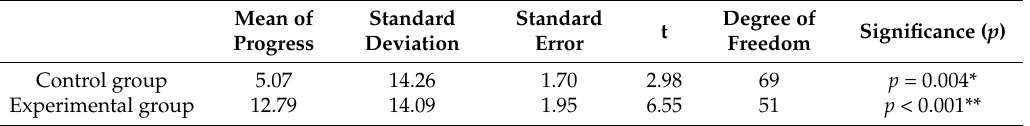
Table 3. Statistical results of the paired sample